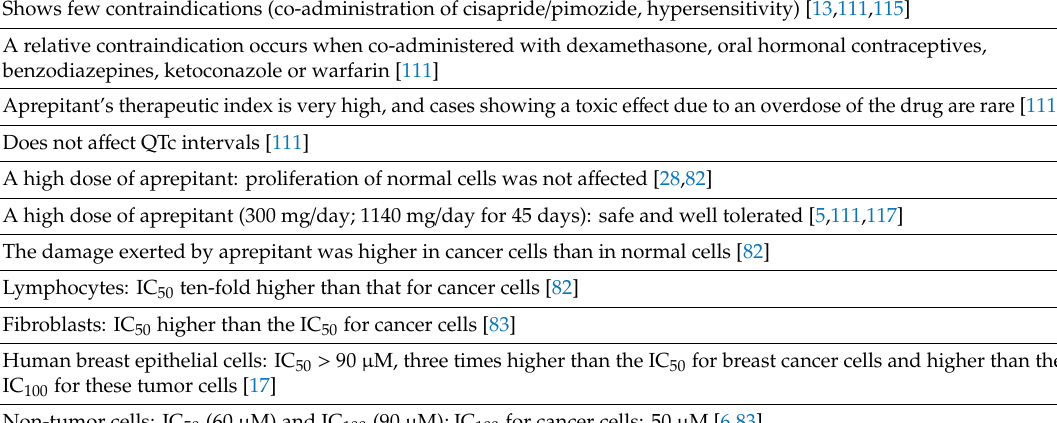
Table 3. Safety of